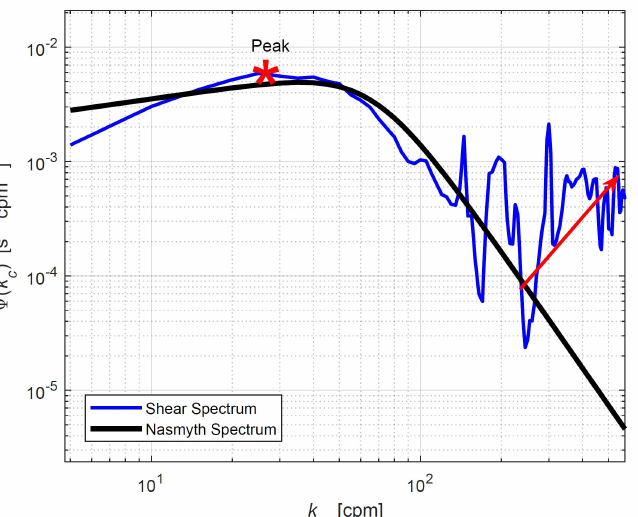
Figure 2. Comparison of the Shear spectrum with Nasmyth spectrum for < U > = 0.167 m/s at x / M = 37 and depth of z = 0.25 m. K c is wave number in the unit of cpm that it equals to K c = K / ( 2 π ) . The spectrum peak is shown with a red star, and the red arrow shows the rising part of the